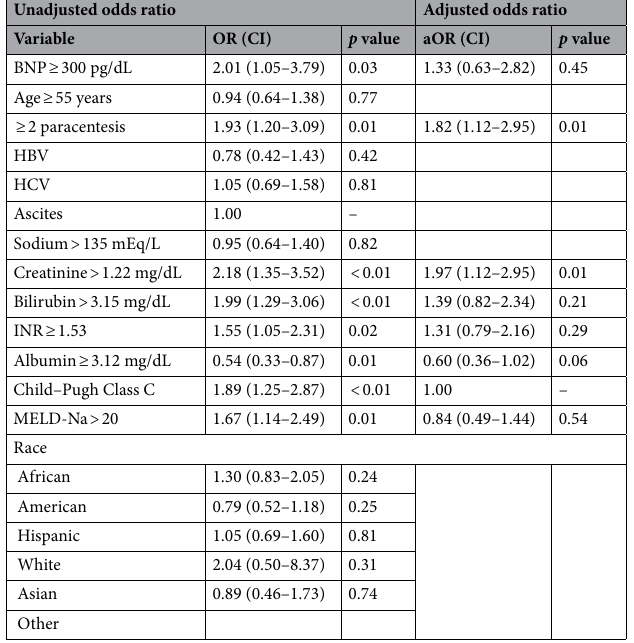
Table 4. Univariate and multivariate Cox Regression Analysis for 90-day requirement of paracentesis. CI confidence interval, BNP brain natriuretic peptide, HBV hepatitis B, HCV hepatitis C.